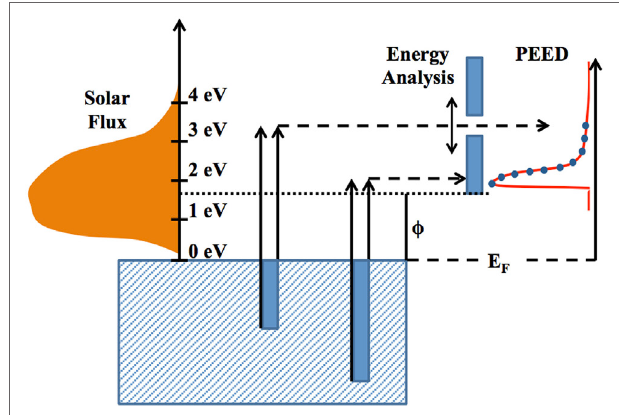
FigUre 3 | Energy scale schematic of the photoemission process performed in this study.